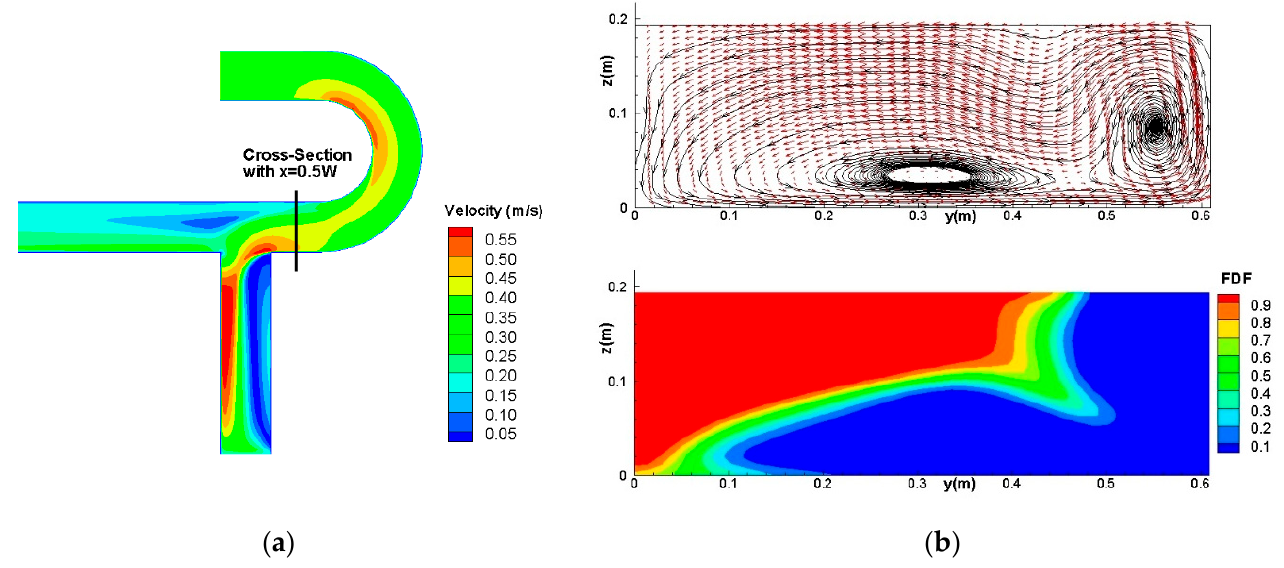
Figure 9. Planview of the (a) model domain and velocity field and (b) predicted secondary flow (top) and fish distribution function(bottom) at the main channel cross-section 0.5 W upstream of the juncture (looking downstream); the flow diversion rate is 50%.